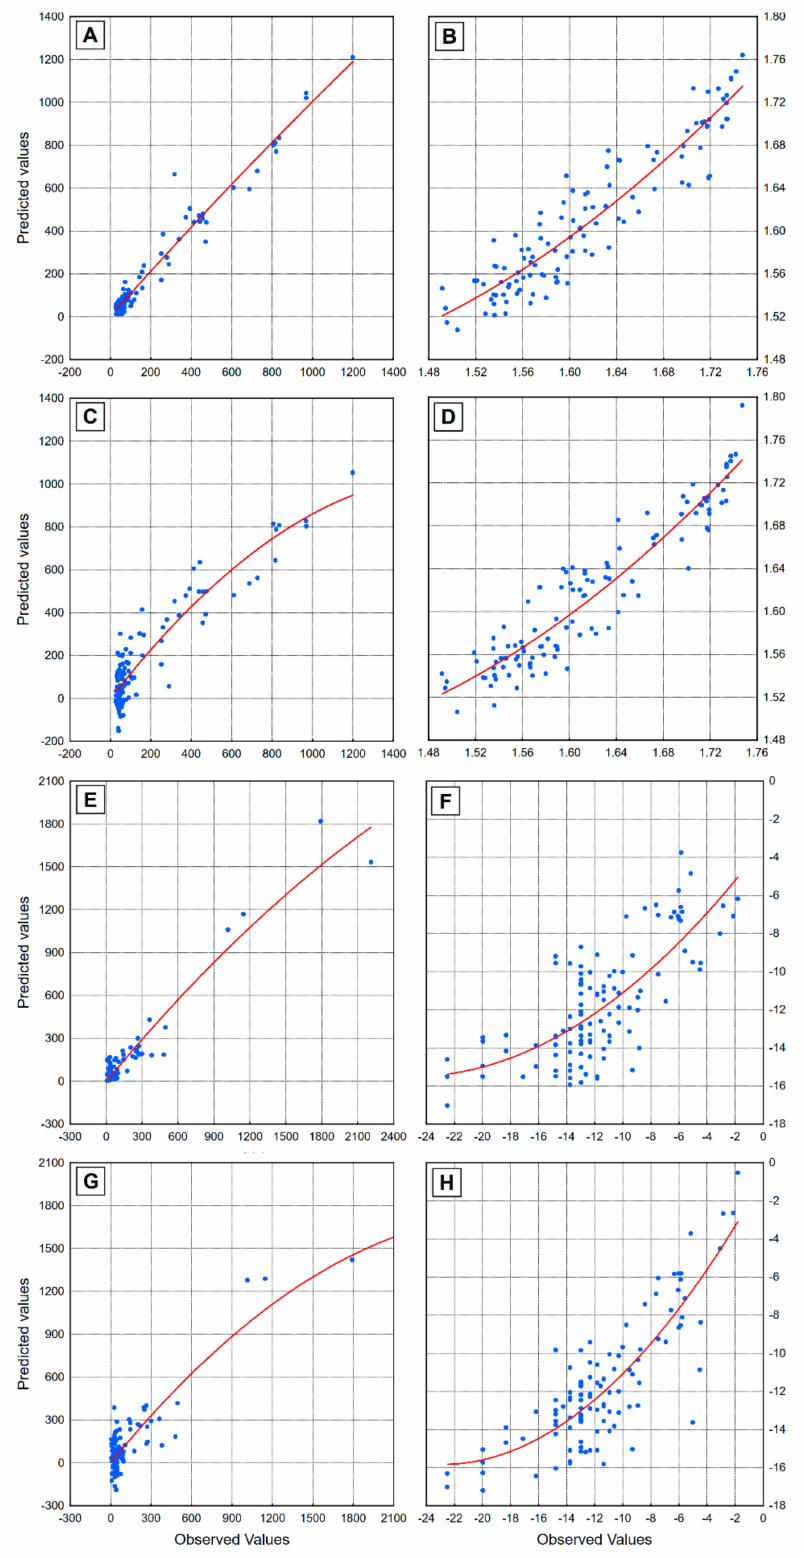
Figure 3. Regression plots of predicted vs. observed values for Lead and Titanium according to the prediction methods and transformations: ANN-MP ( A —Pb / Raw data, B —Pb / Box-Cox values, E —Ti / Raw data, F —Ti / Box-Cox values) and MPR ( C —Pb / Raw data, D —Pb / Box-Cox values, G —Ti / Raw data, H —Ti / Box-Cox